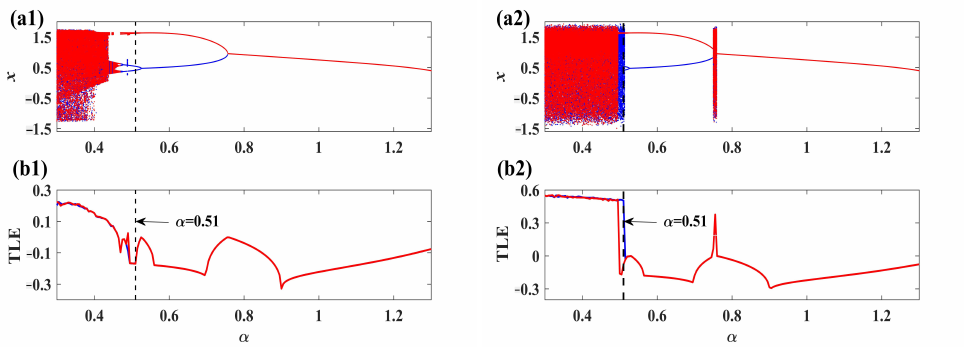
Figure 9. Bifurcation diagrams and the TLE with the variation of electromechanical coupling co- efficient α . ( a1 , a2 ) Multivalued bifurcation diagram of DR and EMR ( σ = 0.01); ( b1 , b2 ) Mul- tivalued TLE of DR and EMR ( σ = 0.01). The blue dots and red dots are obtained under the initial conditions [ x 0 , x 1 , x 2 , x 3 , x 4 ] = [ − 1.0,0,0,0,0 ] , [ ˙ x 0 , ˙ x 1 , ˙ x 2 , ˙ x 3 , ˙ x 4 ] = [ − 1.0,0,0,0,0 ] , [ v ] = [ 1.0,0,0,0,0 ] (IC-3) and [ x ] = [ − 0.5,0,0,0,0 ] , [ ˙ x ] = 0 , v 1 , v 2 , v 3 , v 4 0 , x 1 , x 2 , x 3 , x 4 0 , ˙ x 1 , ˙ x 2 , ˙ x 3 , ˙ x 4 [ 1.0,0,0,0,0 ] , [ v ] = [ 1.0,0,0,0,0 ] (IC-4), 0 , v 1 , v 2 , v 3 , v 4